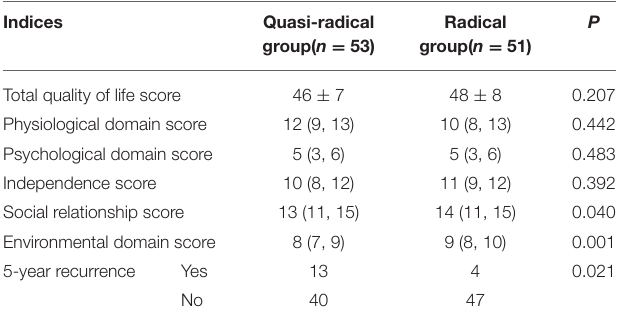
TABLE 3 | Comparison of quality of life scores and 5-year recurrence rate between the two groups.